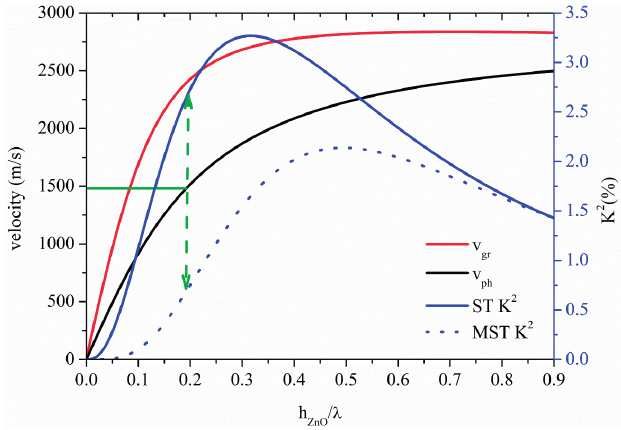
Figure 7. Phase and group velocity, and K 2 dispersion curves of the A 0 mode propagating along the MST and ST configurations on ZnO plate.